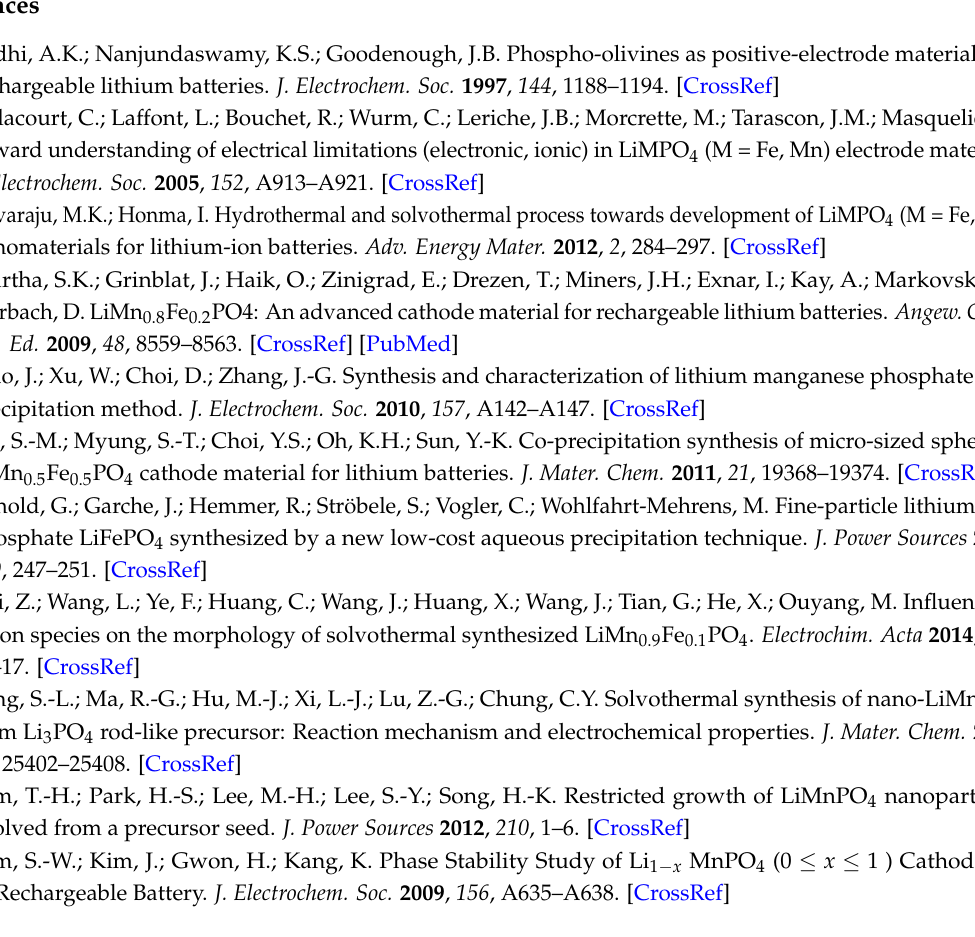
LiMnPO 4 nano-plates and LiFePO 4